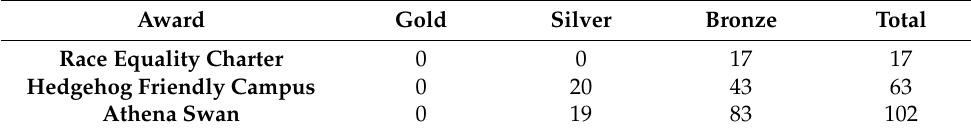
Table 1. Number of UK universities with gold, silver or bronze awards from the Race Equality Charter, the Hedgehog Friendly Campus initiative, and Athena Swan. Award Gold Silver Bronze Total